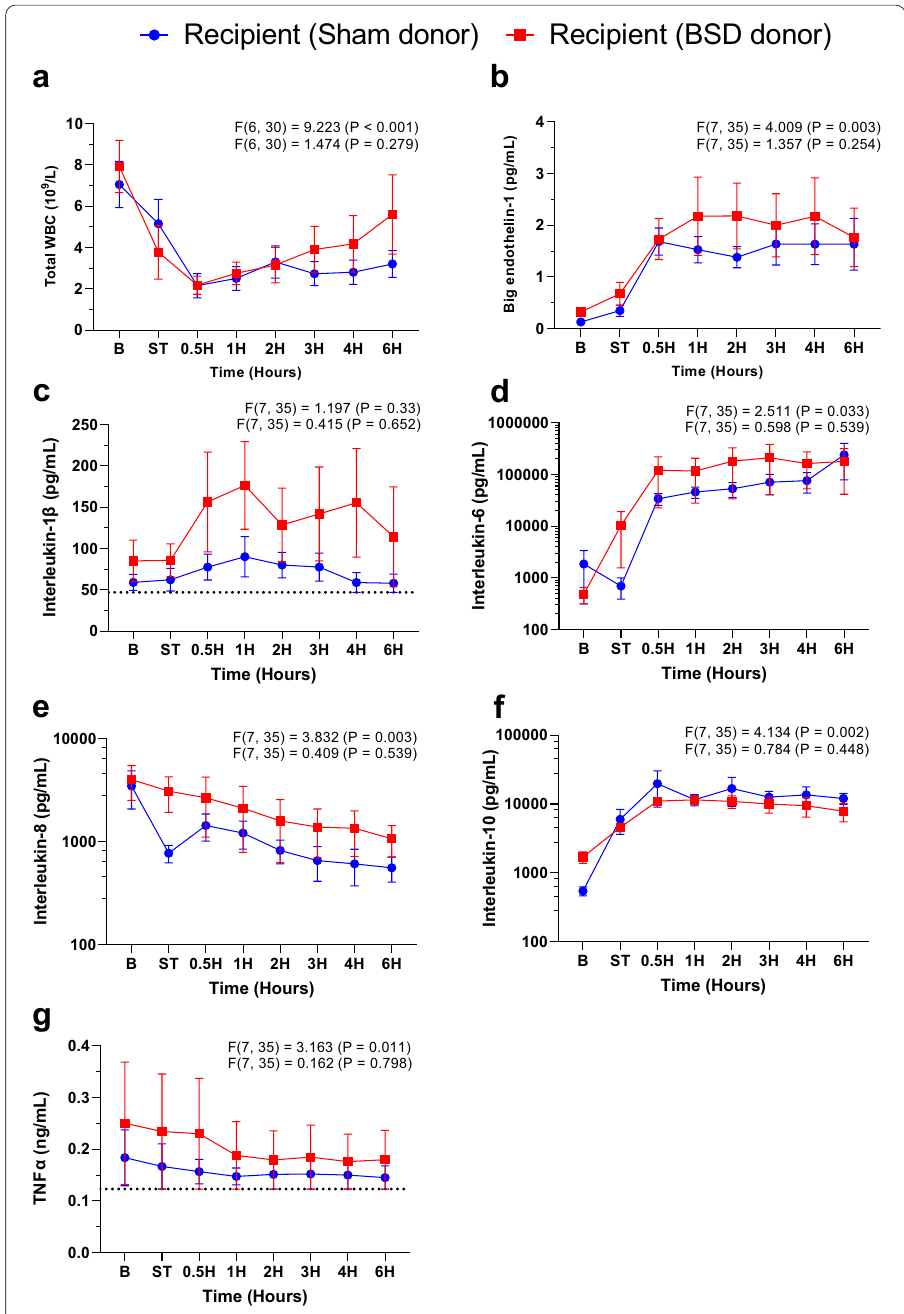
Fig. 6 Systemic inflammation in recipients post‑HTx. Changes in plasma a total white blood cells (WBC, 10 9 /L); b big endothelin‑1 (BET‑1, pg/mL); c interleukin 1β (pg/mL); d interleukin‑6 (pg/mL); e interleukin‑8 (pg/mL); f interleukin‑10 (pg/mL); and g TNFα (ng/mL) following confirmation of donor BSD (or sham). Data are expressed as mean SEM, n 4/group. Top F and p values on each graph represent effect of time, and ± = bottom F and p values represent differences between BSD vs. sham over time. B Baseline, ST stabilisation 1 h following completion of instrumentation procedures in recipient, 0H—successful weaning from CPB. Dotted lines on c and g represent the lowest detectable limit of the respective cytokine